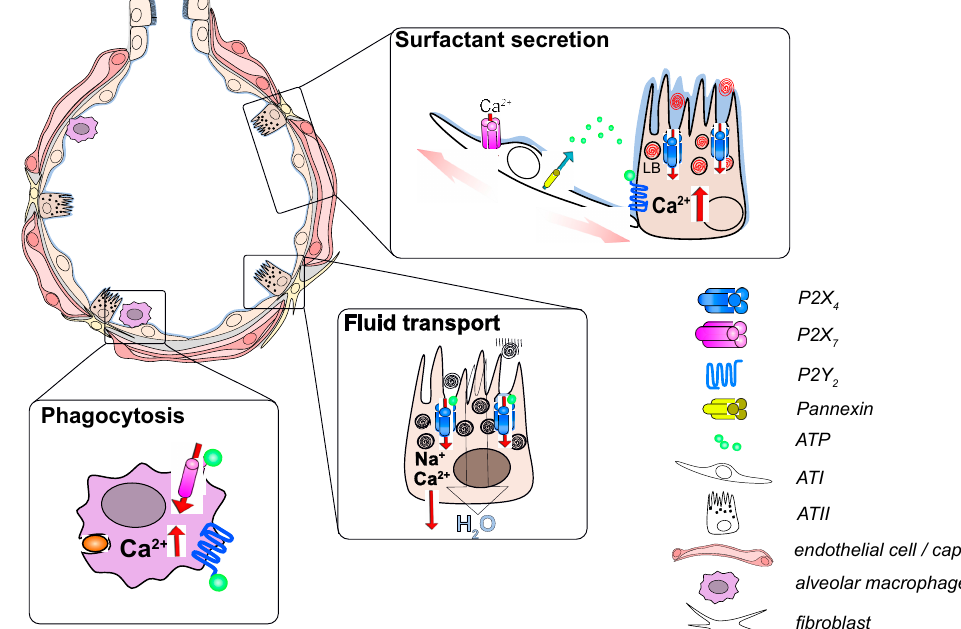
Figure 1. Functional relevance of P2 receptor signaling in the alveolus. Inflation of the alveolus leads to stretch-induced release of ATP (adenosine triphosphate) from alveolar epithelial cells which activates P2Y 2 receptors on ATII (type II) cells. The resulting Ca 2 + release from the endoplasmatic reticulum stimulates LB exocytosis. Subsequent activation of P2X 4 receptors on the limiting membrane of fused LBs results in a fusion-activated Ca 2 + -entry (FACE) which facilitates release of surfactant from fused LBs. FACE also results in transepithelial cation transport leading to fluid resorption from the alveolar lumen to promote activation of secreted surfactant. Activation of P2X 7 and P2Y 2 receptors on AMs results in an increase in intracellular Ca 2 + that facilitates phagocytosis of airborne particulates.